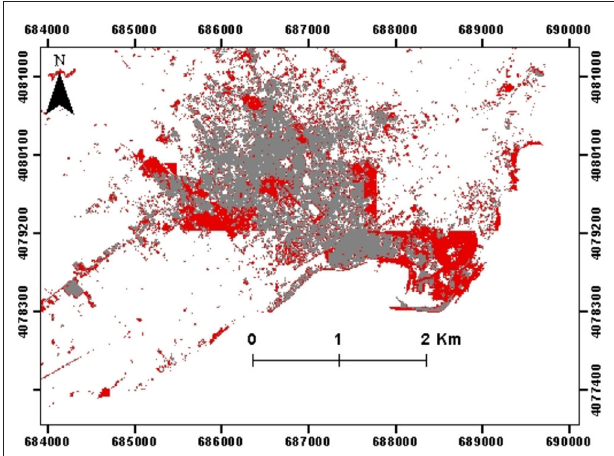
FIGURE 4 | The urban change detection map of Edge segmentation method showing urban expansion of Kelibia city in 2016 (red) on the basis of the urban extent of 2012 (gray).